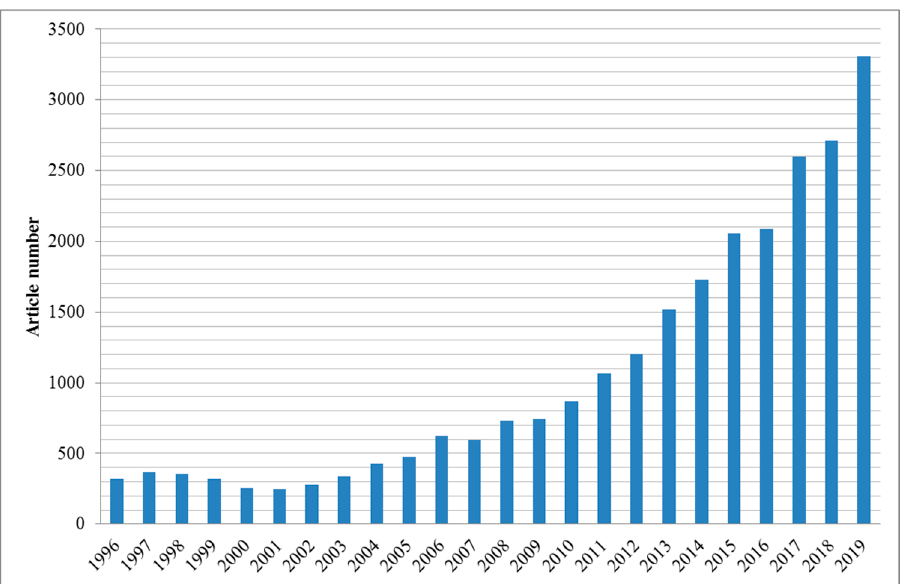
Figure 1. Worldwide PCM research articles between 1996 and 2019.